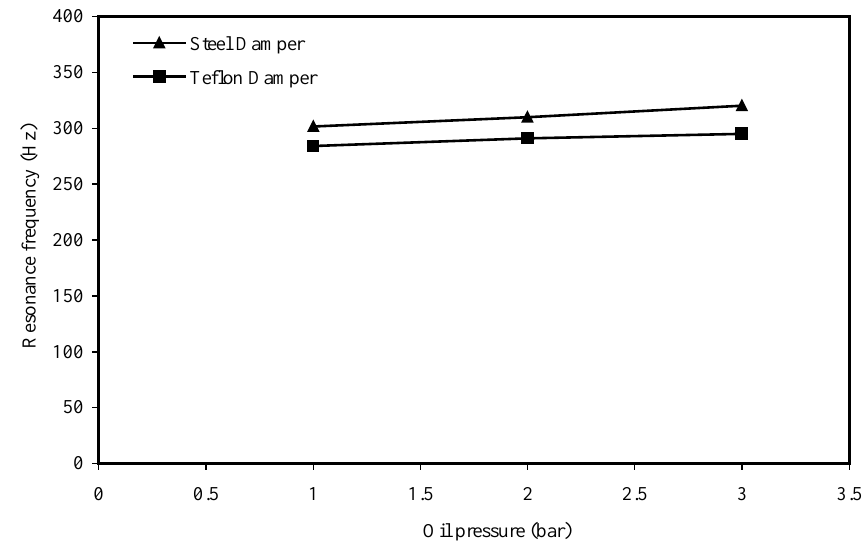
Fig. 9. Oil pressure effect on resonance frequency for steel and Teflon dampers.